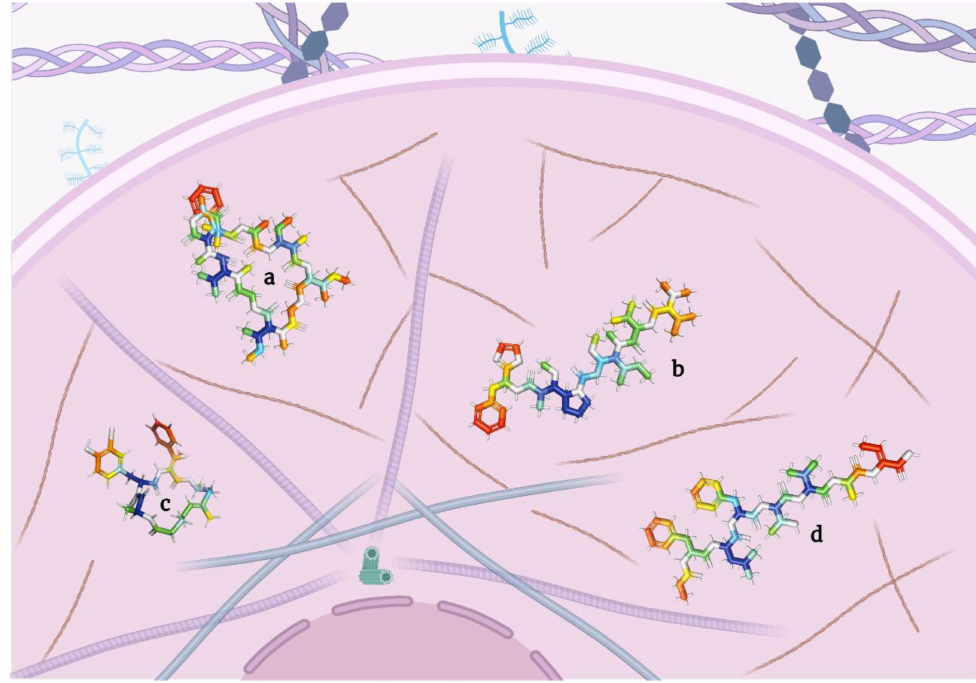
Figure 6. Models of depsipeptides inducing microfilament disruption in tumor cells. ( a ) Desmethoxy- majusculamide C; ( b ) Dolastatin 10; ( c ) Miuraenamide; ( d ) Nobilamide